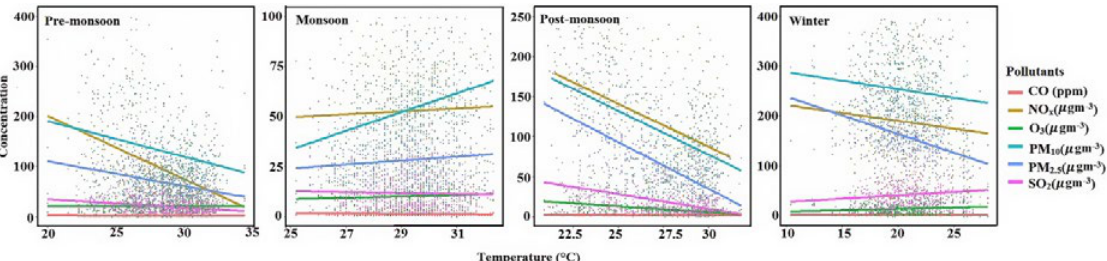
Fig. 5: Correlation between air pollutants concentration and seasonal temperature a) pre ‐ monsoon (March ‐ May) b) monsoon (June ‐ September) c) post ‐ monsoon (October ‐ November) and d) winter (December ‐ February)